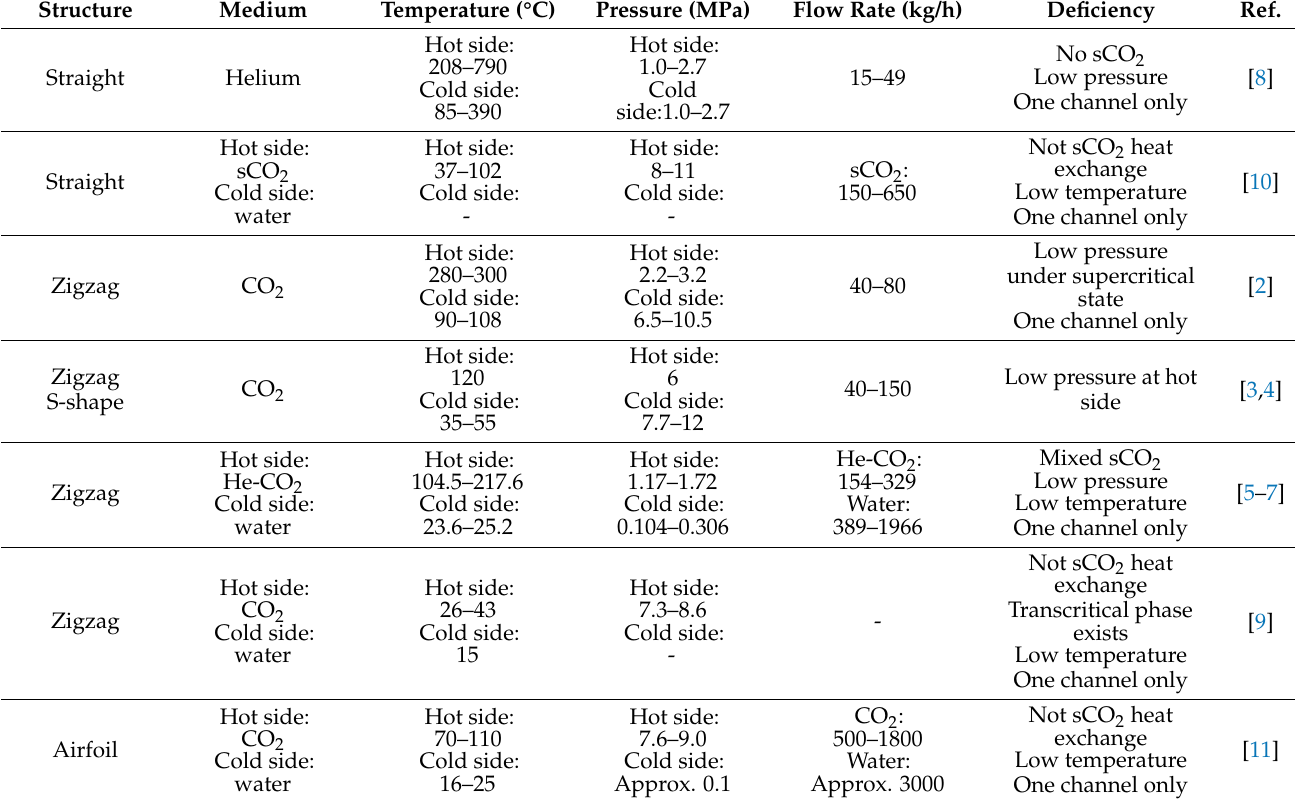
Table 1. Experimental research on the thermal–hydraulic performance of PCHE.